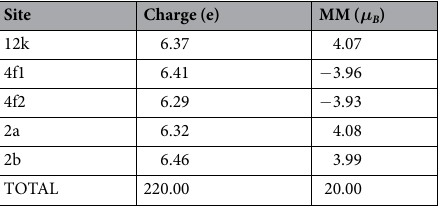
Table 2. Bader charge and magnetic moment of each Fe site and total values per formula unit including also the oxygen and Sr